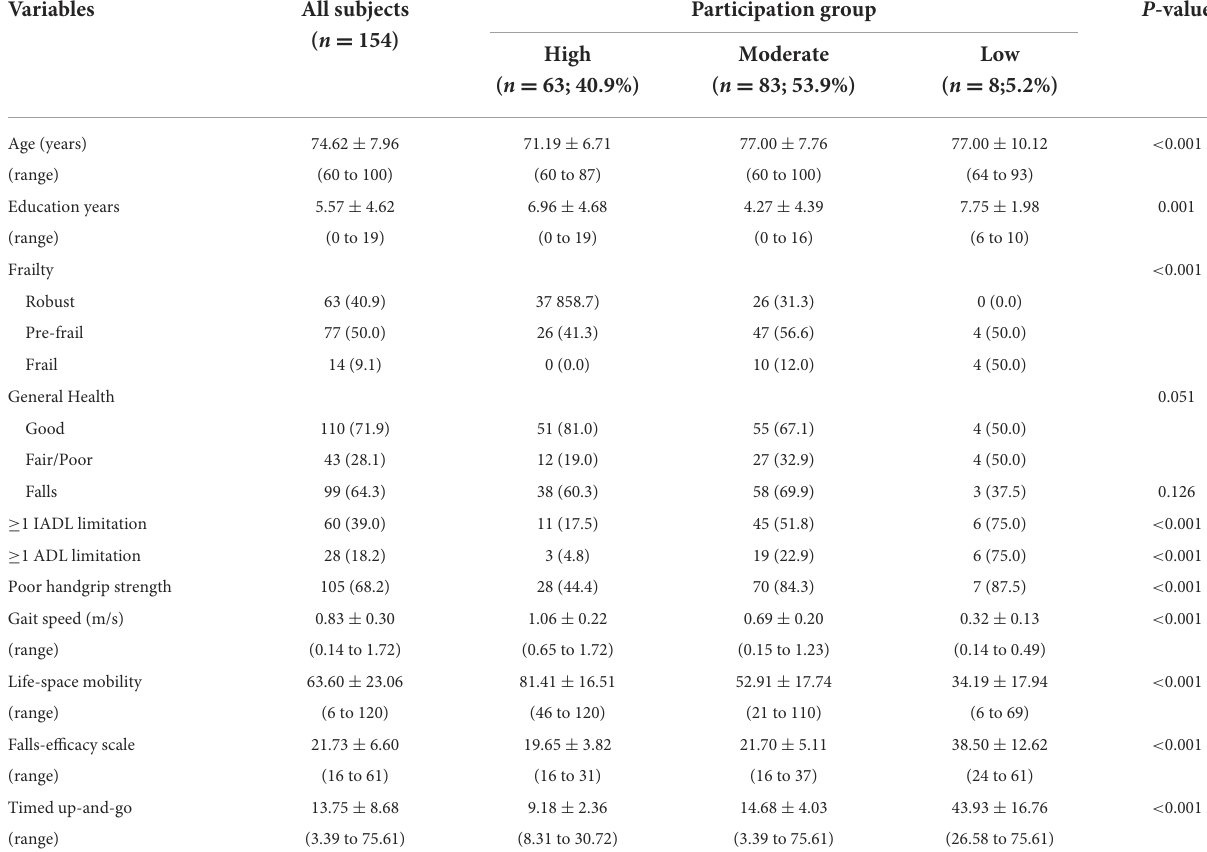
TABLE 2 Latent class analysis co-variates by participation group.